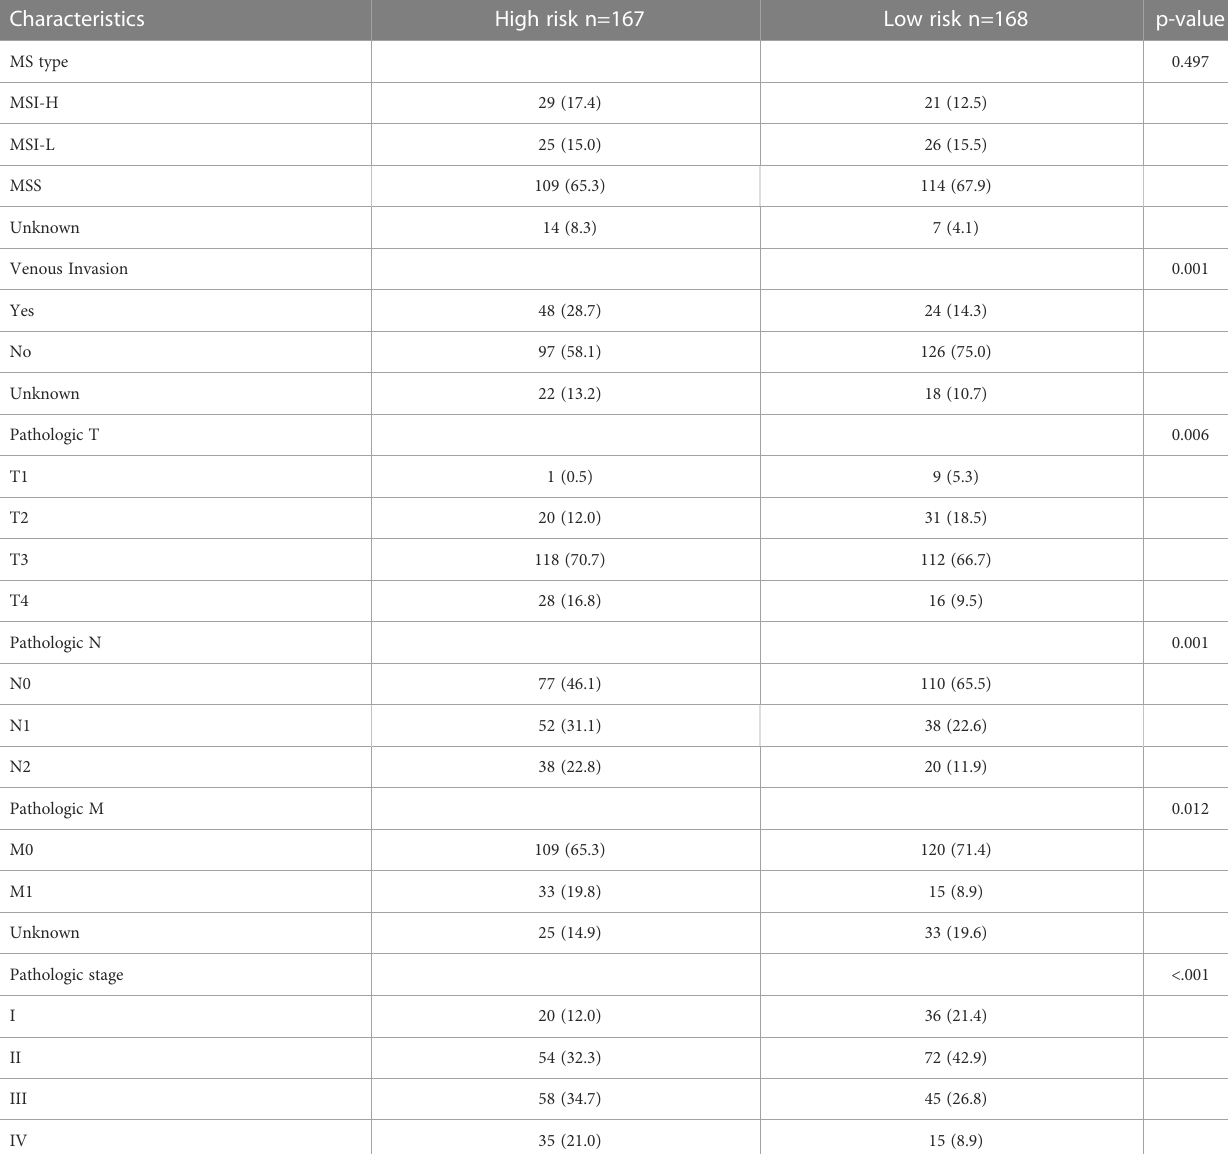
TABLE 1 Comparison of basic clinicopathological features in high-risk and low-risk groups.